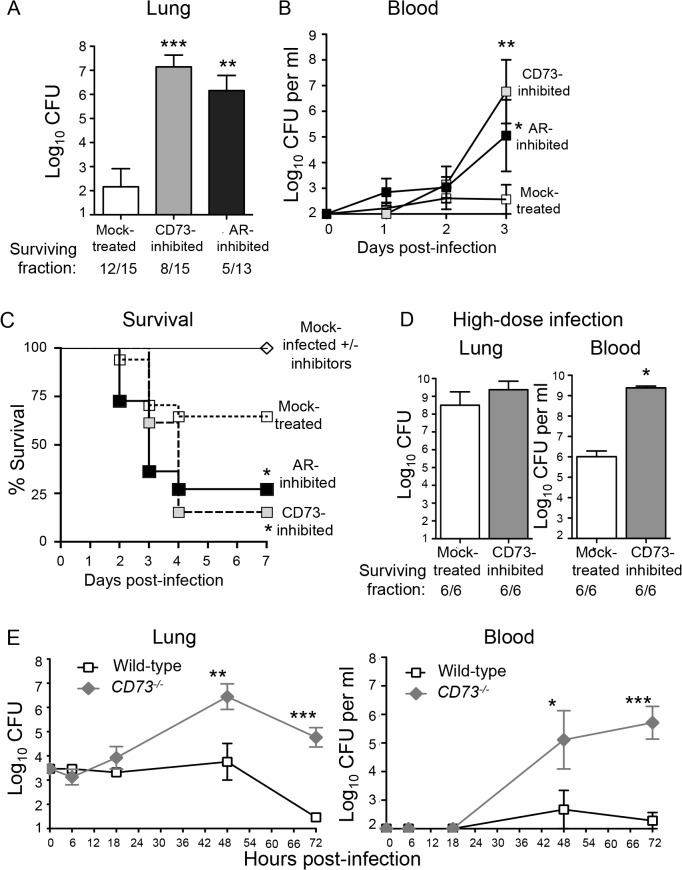
Inhibition of EAD production or signaling enhances susceptibility of mice to S. pneumoniae lung challenge.(A-D) Wild-type C57BL/6J mice were either treated with the CD73 inhibitor (α,β- methylene ADP), the pan adenosine receptor (AR) inhibitor (CGS 15943) or mock-treated with a vehicle control. (A) Bacterial loads in the lungs of a group of mice were determined 3 days after I.T. inoculation with 5x103 CFU of S. pneumoniae TIGR4. (B-C) Bacteremia (B) and survival (C) were monitored over time for another group of mice. Pooled data from 3 separate experiments (n = 6–12 mice per group) are shown. (D) Mice were challenged I.T. with a high dose, ~1x107 CFU of S. pneumoniae TIGR4 and bacterial burdens in the lungs and blood were assessed at two days post-infection. Pooled data from two separate experiments (n = 6 mice per group) are shown. Below figures A and D are indicated the fraction of surviving mice within each group. (E) CD73
-/- mice and wild-type B6 controls were inoculated I.T. with 5x103 CFU of S. pneumoniae TIGR4 and bacterial burdens in the lungs and blood were measured at the indicated time points post-infection. Data pooled from 3 separate experiments (n = 6–9 mice per group) are shown. None of the mice died within the time frame of these (E) experiments. Data represent means +/- SEM. Means that are significantly different from mock-treated group (A-B) or wild-type control group (E) by student t-test are indicated by asterisks (*** = p< 0.0001; ** = p< 0.001; * = p<0.05). In Panel C, a survival rate significantly (p<0.05) different from mock-treated controls by Log-rank (Mantel-Cox) test is indicated by asterisk.